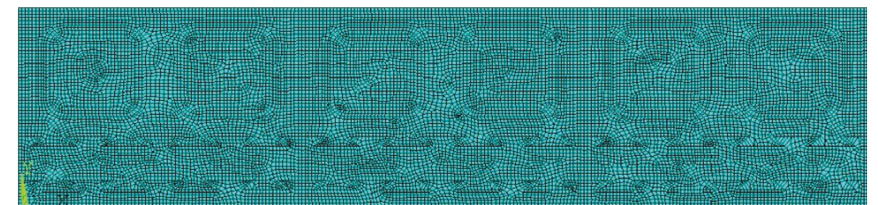
Figure 14: Grid diagram of the thermal analysis unit.